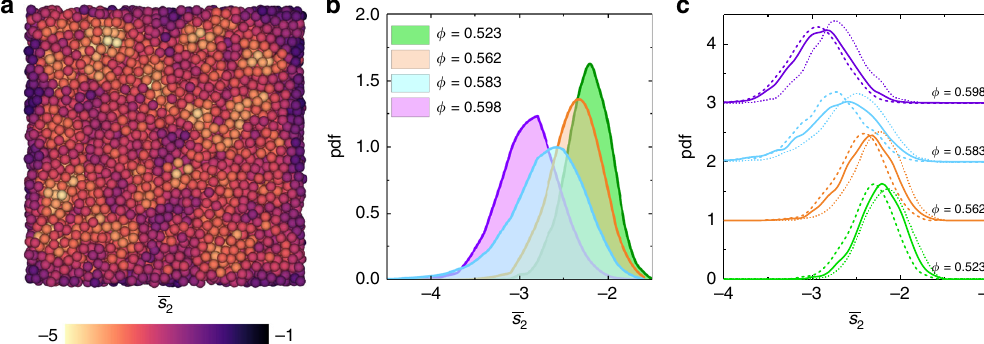
Fig. 5 Two-body excess entropy. a Spatial distribution of locally averaged two-body excess entropy s 2 for volume fraction 0.598. b Probability distributions of s 2 for a range of volume fractions. c Probability distributions of s 2 for a range of volume fractions for the whole particle population (solid line), particles identi fi ed in defective icosahedra (dashed line) and particles not identi fi ed in defective icosahedra (dotted line)